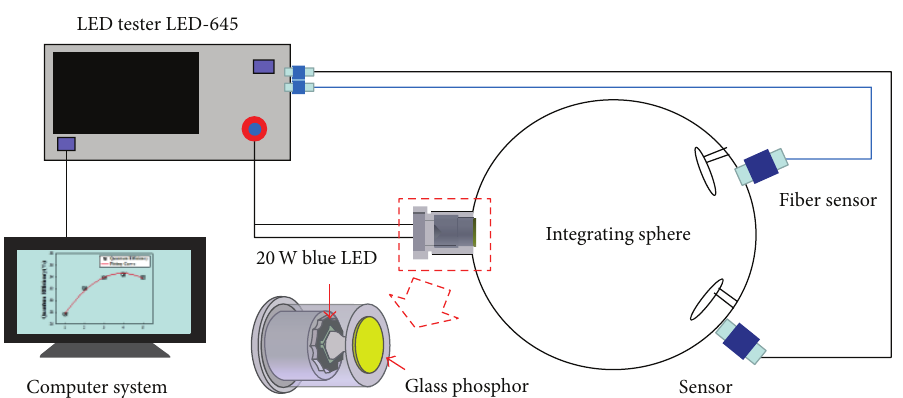
Figure 1: The test chamber schematic for optical